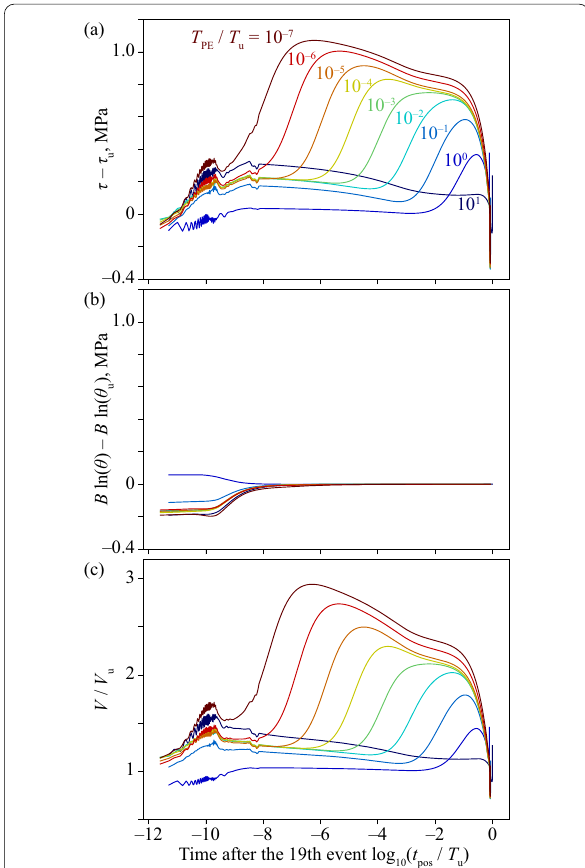
Fig. 7 Effect of PE at x = 0.5 (cid:31) x ag with the aging law and various fluid mobility as a function of the time after the 19th earthquake. Poroelastic diffusion time T u = R 2 / c is indicated by color as shown in a . a Shear stress, b shear strength, and c Slip rate relative to the undrained